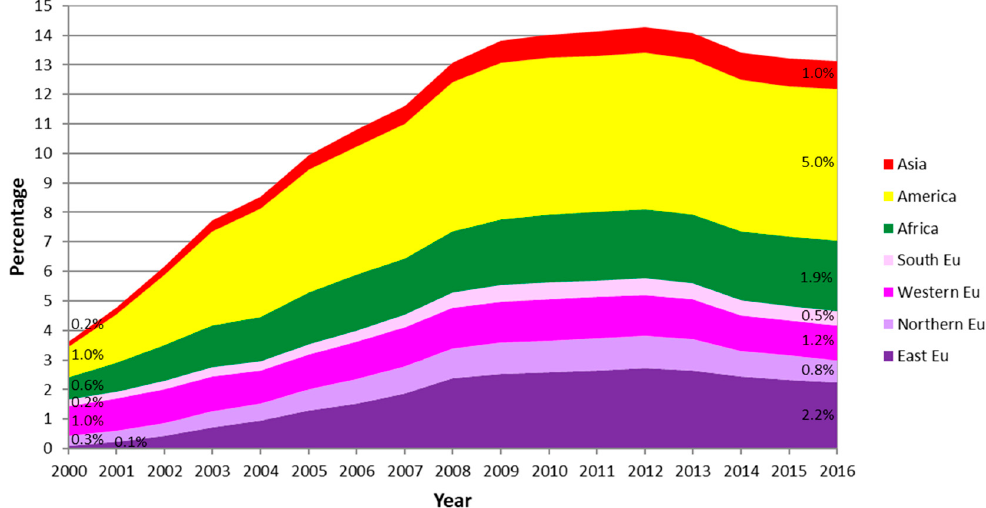
Figure 1. Evolution of the immigrant population of both sexes in Spain according to region of birth for the period 2000–2016. the period